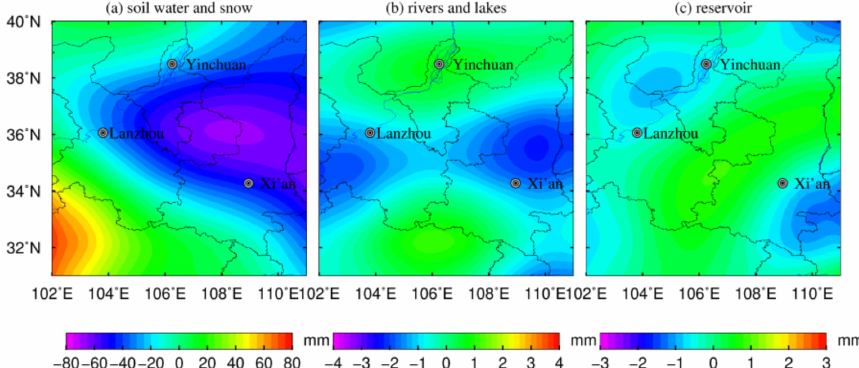
Figure 8. Spatial distribution of water storage in surface water, rivers, lakes, and reservoirs. The spatial distribution of the TWS changes derived from GRACE after recovering the leakage signal are shown in Figure 9. Taking 2011 as an example, the spatial changes in TWS from GRACE in February, May, August, and November are given in the figure.